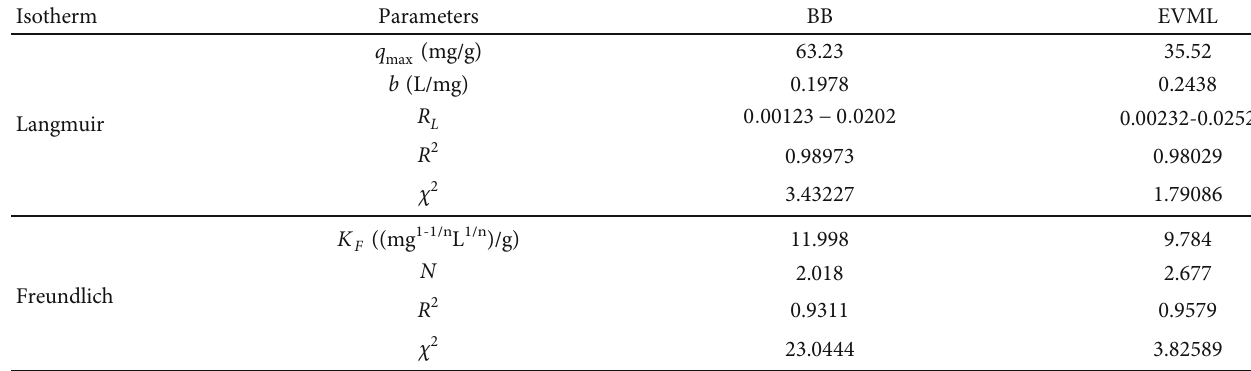
Table 3: Important parameters derived from Langmuir and Freundlich model fi